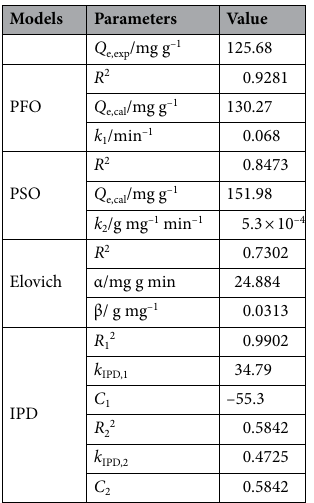
Table 2. Kinetics adsorption parameters (pH = 5.0, C 0 = 50 mg –1 L, V = mL, W = mg, temperature = 25 °C, shaking speed = 180